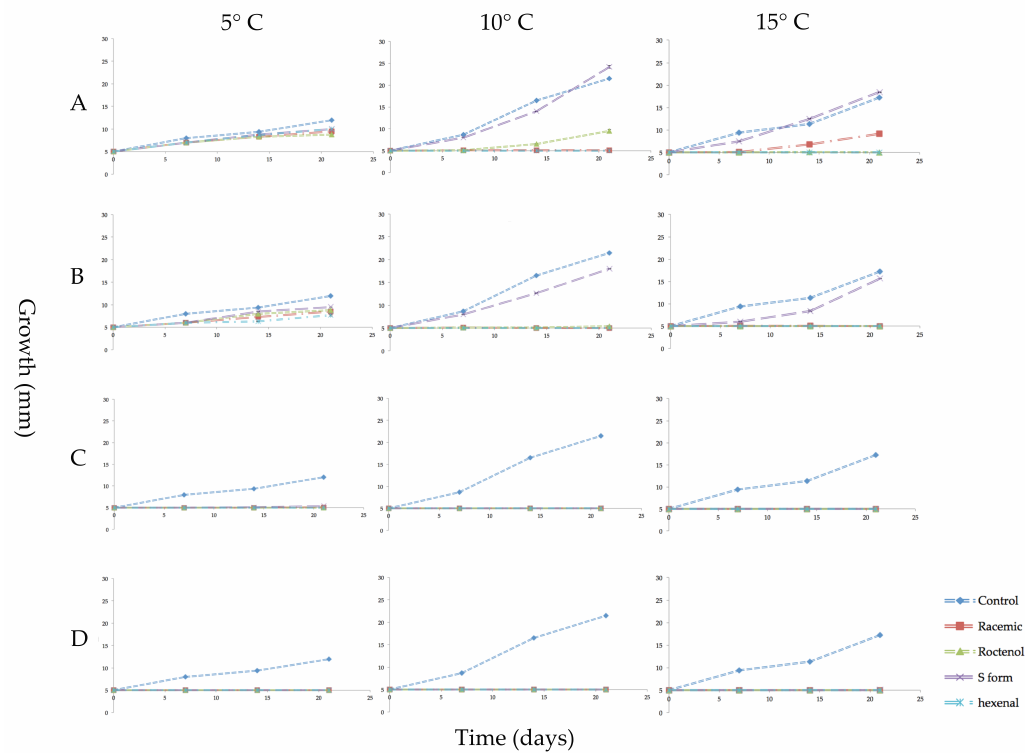
Figure 2. Growth in millimeters (mm) of mycelial plugs of Pseudogymnoascus destructans exposed for 3 weeks to vapors of racemic 1-octen-3-ol, ( R )-( − )-1-octen-3-ol ( R form), ( S )-(+)-1-octen-3-ol ( S form), or trans -2-hexenal and cultured at 5, 10 or 15 ◦ C. Error bars indicate the standard error of the mean. VOC treatments as follows: ( A ) 0.04 µ mol/mL of the three forms of 1-octen-3-ol or 0.05 µ mol/mL of trans -2-hexenal; ( B ) 0.08 µ mol/mL of 1-octen-3-ol or 0.1 µ mol/mL trans -2-hexenal; ( C ) 0.4 µ mol/mL 1-octen-3-ol or 0.5 µ mol/mL trans -2-hexenal; ( D ) 0.8 µ mol/mL 1-octen-3-ol or 1.0 µ mol/mL trans -2-hexenal.